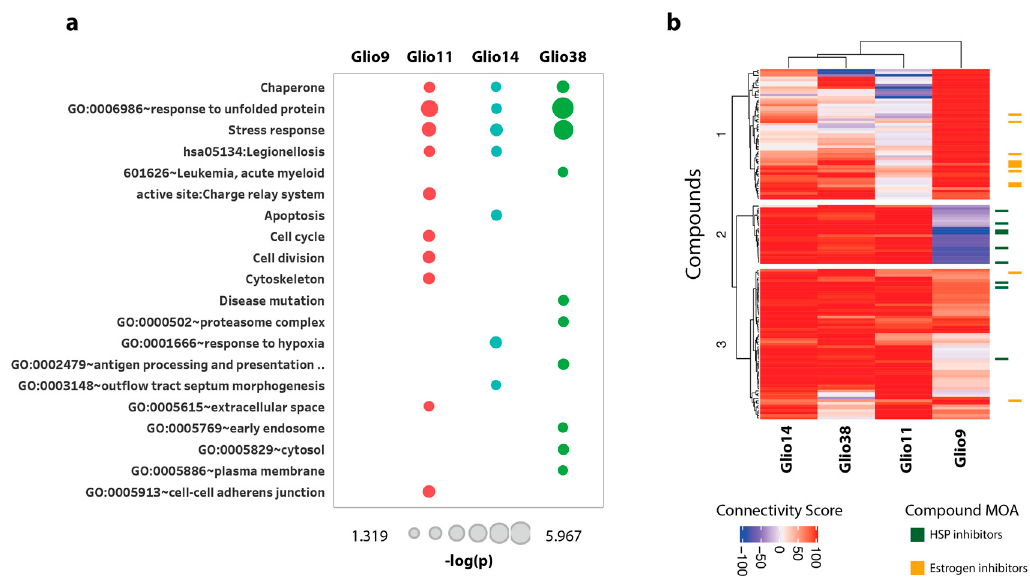
Figure 6. Bis-chalcone 4j induce similar transcriptional responses only in the neurosphere cell lines. ( a ) The individual gene expression signatures for each condition were subjected to functional enrichment analysis using DAVID and the significant ( p -value < 0.05) enrichment terms were ranked based on the numbers of cells that were enriched in them; ( b ) Drug connectivity analysis of 4j indicates ER perturbation of neurosphere cells. Drug connectivity scores were determined by comparing the 4j, 4n and Curcumin transcriptional response to 2911 compounds, part of the CLUE Touchstone dataset. Hierarchical clustering was performed on the 50 most connected compounds for each condition. Glio11, Glio14 and Glio38 cluster together and are highly connected to heat shock protein HSP inhibitors (green). Glio9 was highly connected to estrogen inhibitors (orange).